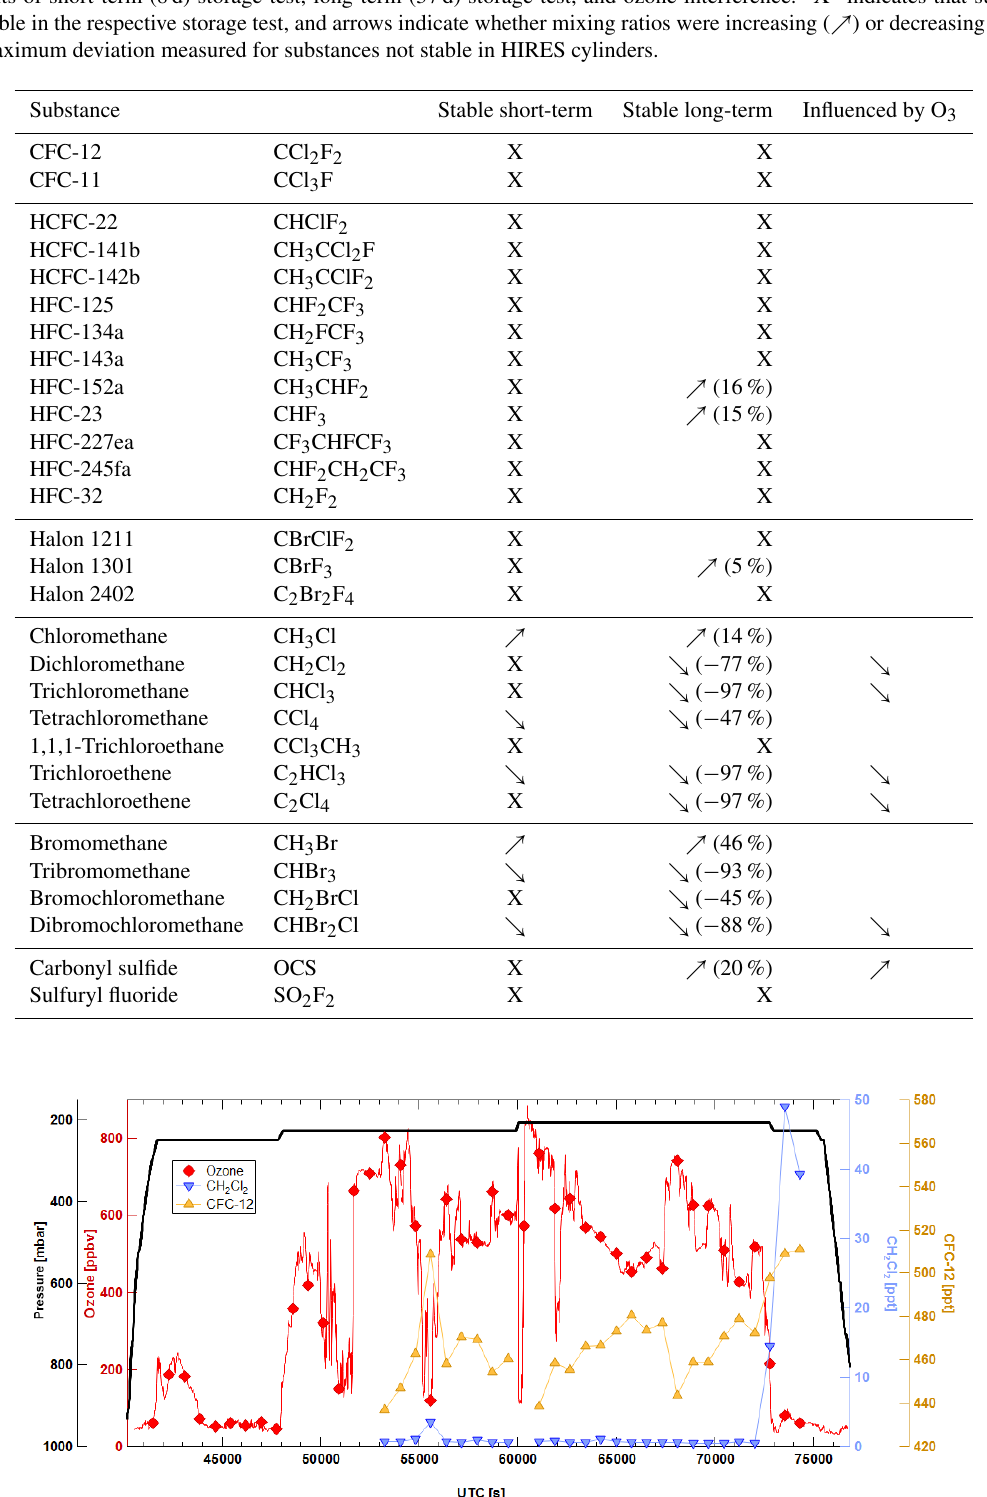
Figure 5. Time series of ozone (red), CFC-12 (yellow), and dichloromethane (blue) during a flight from Munich to Denver on 22 March 2018. Ozone high-resolution data represented by the red line are integrated over the sampling period of each whole-air sample (red